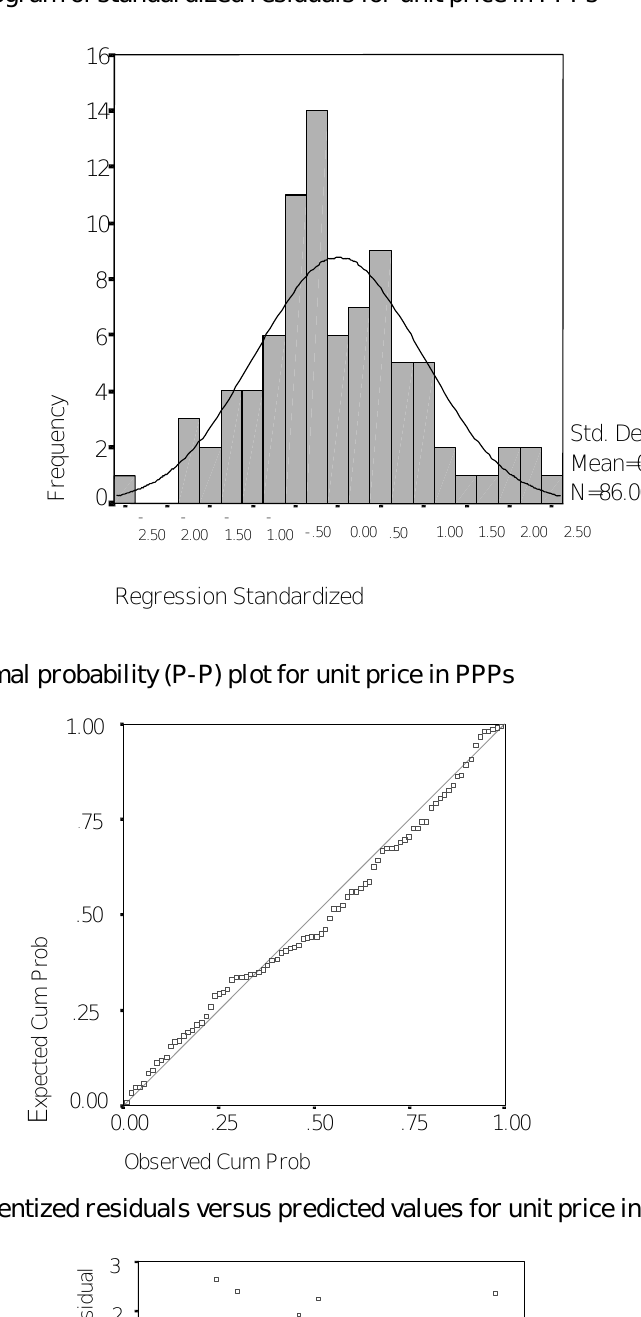
Figure 1: Histogram of standardized residuals for unit price in PPPs